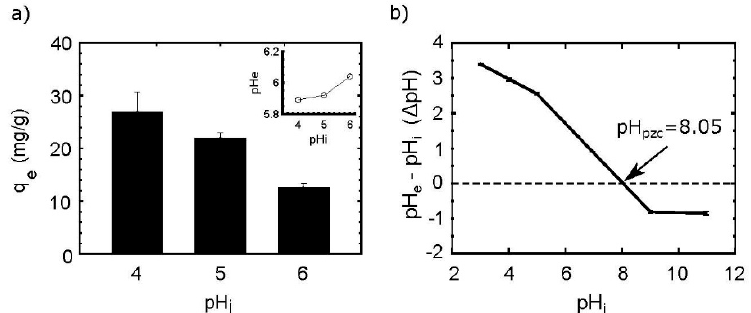
Figure 5. pH dependence of CS-MF. ( a ) pH vs. adsorption uptake, ( b ) pH changes at different pHs in blank solutions. Conditions: ( a ) T: 25 °C, sorbent dosage (SD): 1 g/L; AS: 150 rpm; CT: 24 h; initial concentration (Ci): 50 mg/L; ( b ) T: 25 °C, SD: 1 g/L; AS: 150 rpm; CT: 24 h; electrolyte: NaCl 0.01 M.